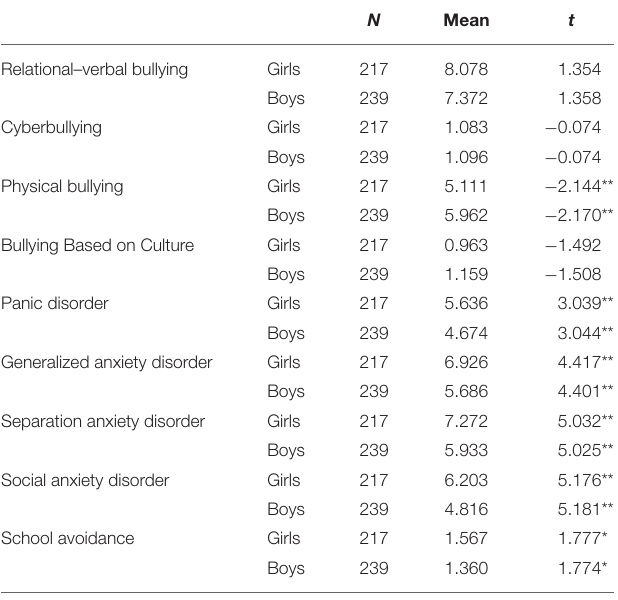
TABLE 6 | Differences between genders.